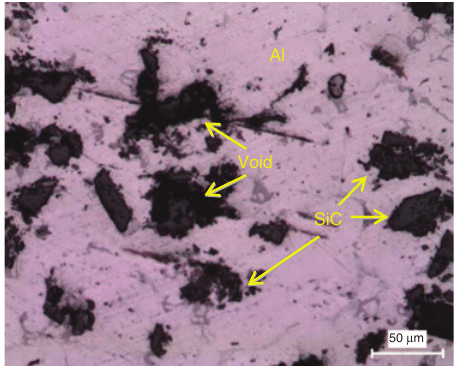
Figure 4 Microstructures of the SiC/Al-Cu-Mg composite produced by stir